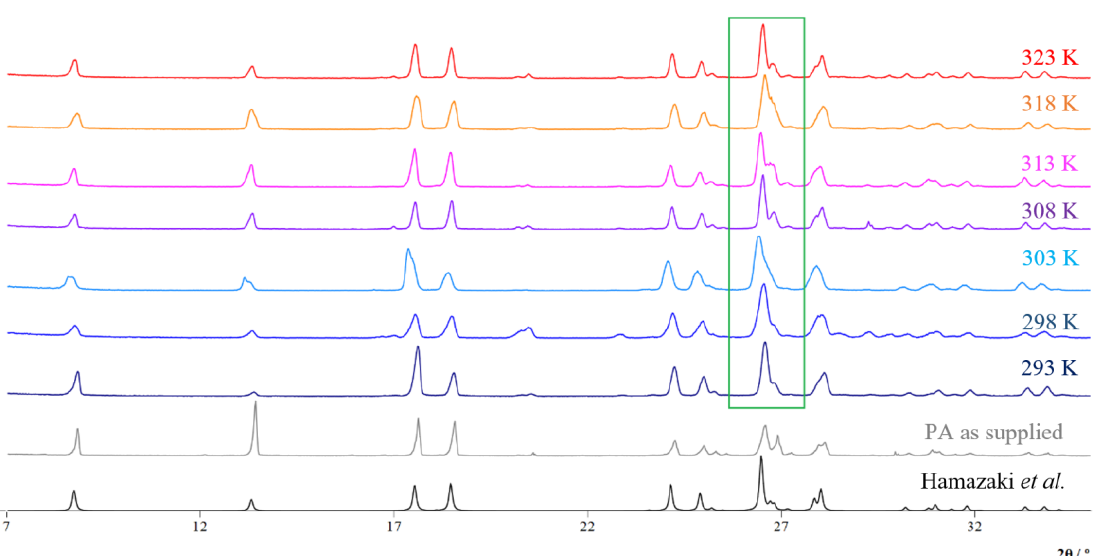
Figure 6. Comparison of X-ray diffraction patterns obtained at 293 ± 2 K for solid forms in equilibrium with the saturated PA ethanol solutions stabilized for one week at different temperatures. The PA as supplied (gray), and the pattern estimated from the SCXRD structure found in the literature [11] (black), are also plotted. All the diffractograms were normalized to the peak of highest intensity ( I n ) and plotted using EasyGraphII [19].